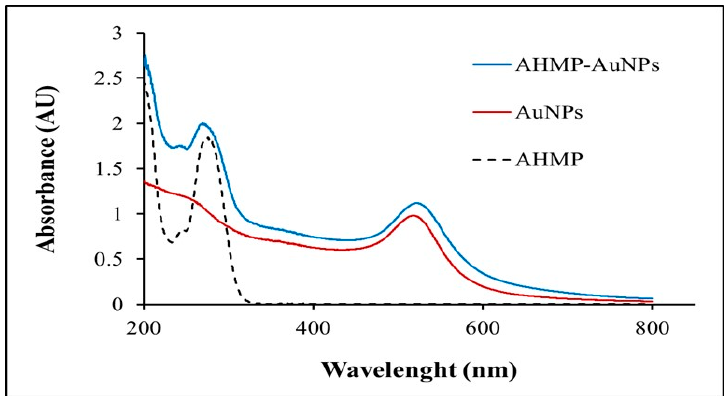
Figure 1. UV–Vis absorption spectra of AHMP, AuNPs, and AHMP-AuNPs.